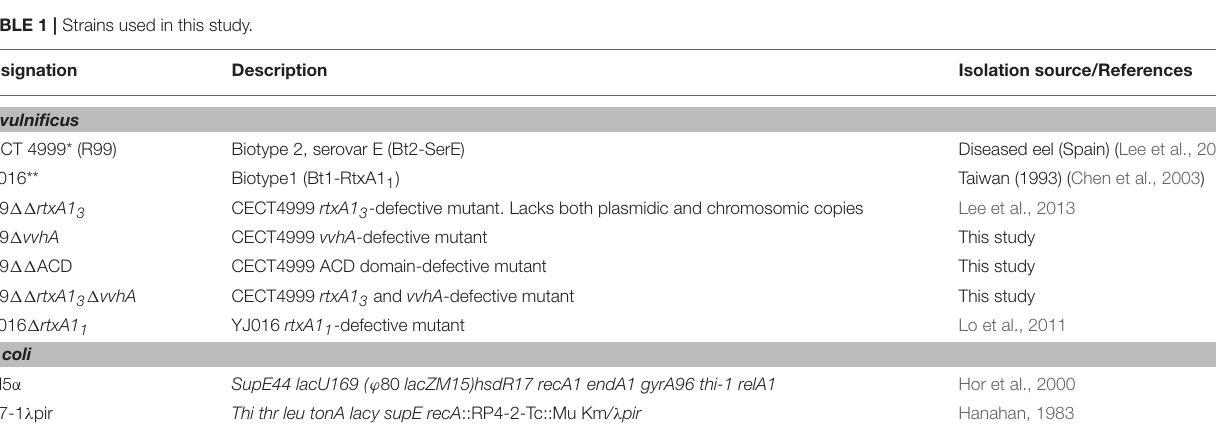
TABLE 1 | Strains used in this